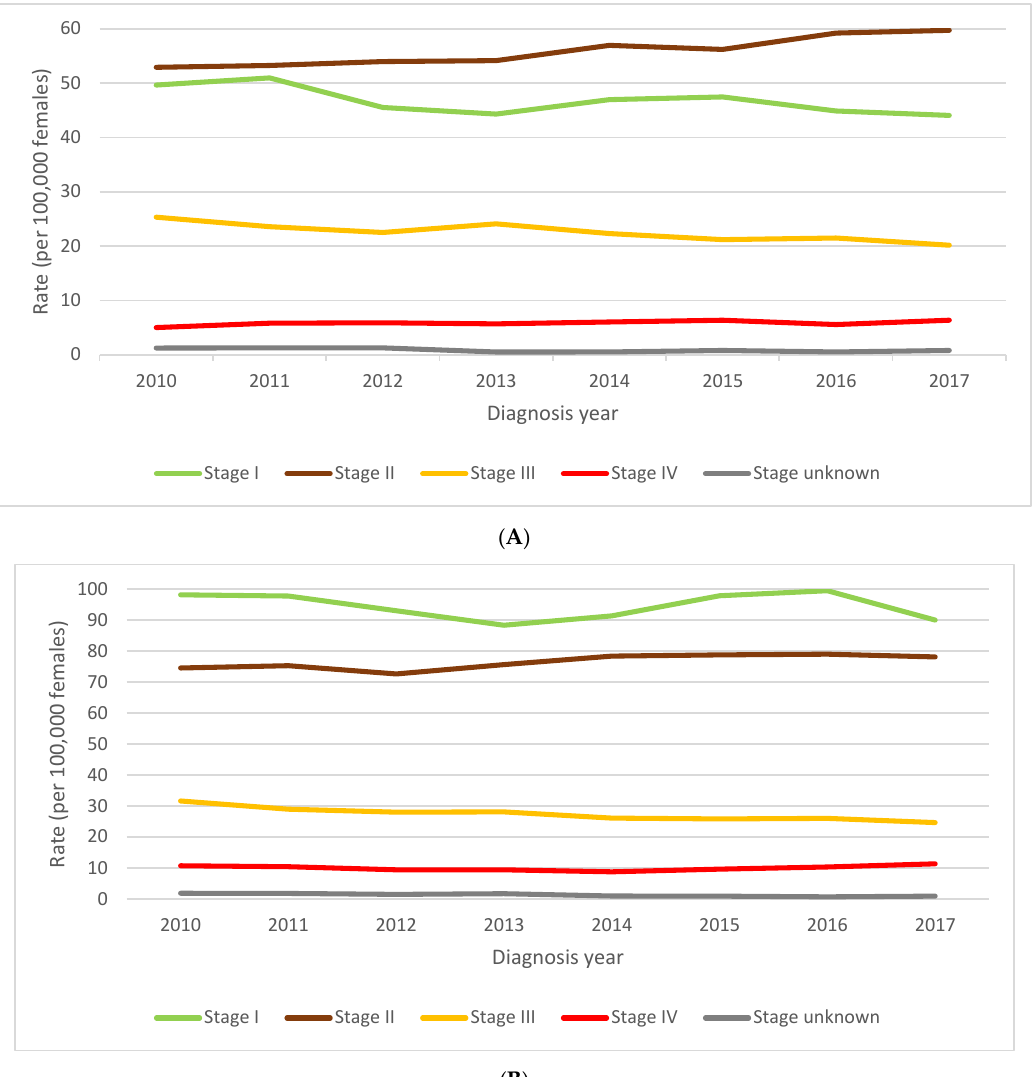
Figure 4. ( A ). Stage-specific female breast cancer incidence rates, ages 40 to 49 years, Canada excluding Quebec, 2010 to 2017. ( B ). Stage-specific female breast cancer incidence rates, ages 50 to 59 years, Canada excluding Quebec, 2010 to 2017. Note: Quebec is excluded because cases diagnosed in Quebec from 2011 onward had not been submitted to the Canadian Cancer Registry. Source: Canadian Cancer Registry (1992 to 2018) at Statistics Canada [42].